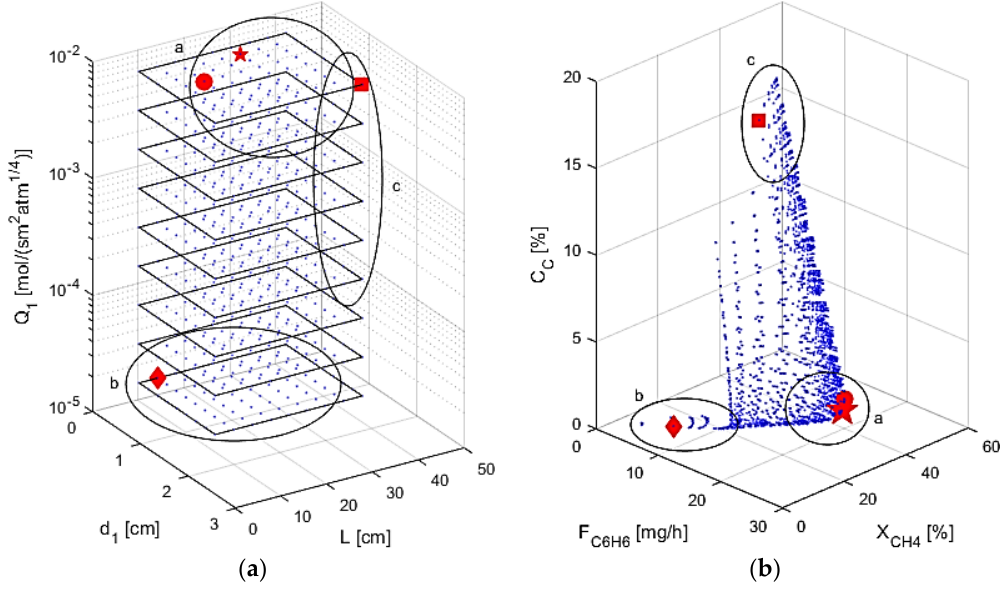
Figure 11. ( a ) AIS—reactor dimensions and M1 permeance; ( b ) AOS—performance criteria. Table 4. Optimal reactor designs and outputs with modified objective functions: Case 1 has equally weighted criteria, as seen in φ; Case 2 has 100 times weight on F C6H6 ; Case 3 has 100 times weight on X CH4 ; Case 4 has 100 times weight on C C .